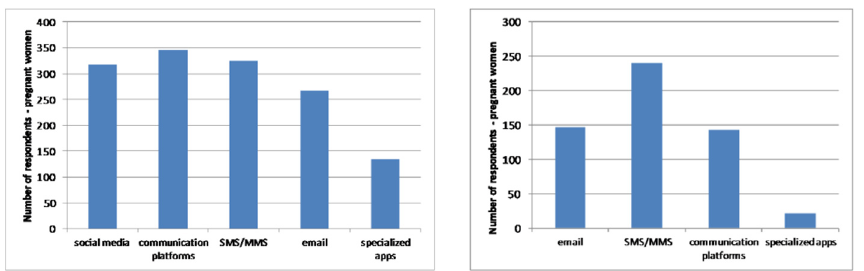
Figure 8. Frequency of pregnant women’ usage of mobile services ( left ) and affinity for mobile communication with doctors ( right ).